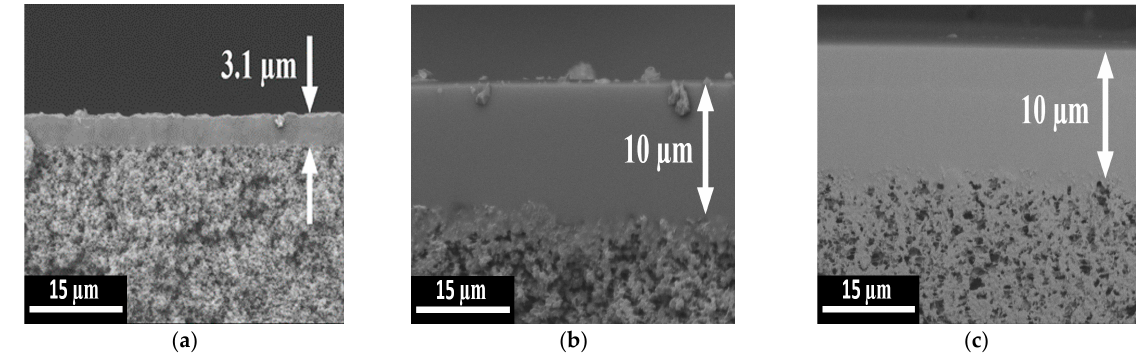
Figure 3. SEM images of cross sections of initial membranes: ( a ) MDK-3; ( b ) PDecMS; ( c ) PHeptMS.